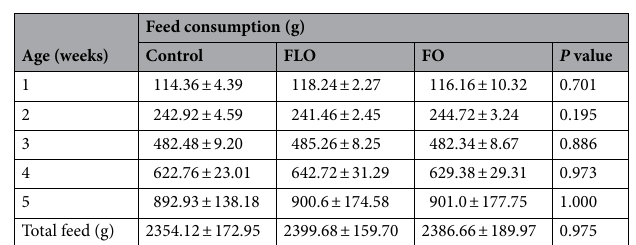
Table 2. The effects of different supplemental oils on the feed consumption at different ages of broilers. Values are means ± SD. FLO flaxseed oil, FO fish oil.